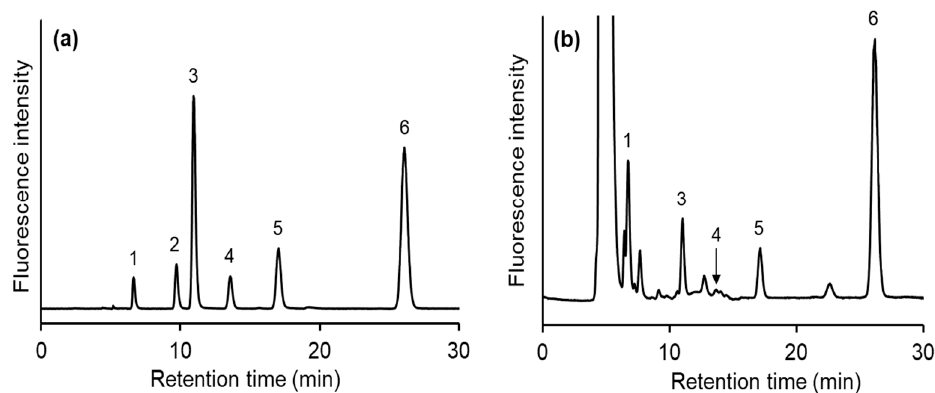
Figure 2. Chromatograms of ( a ) the SBD-thiol standards and ( b ) the K562 cell sample. Mobile phase: 100 mM citric buffer (pH 3.0)/MeOH (95/5, v / v ). Column: InertSustain AQ-C18 (250 × 3.0 mm I.D., 5 µ m). Peaks: 1; SBD-Cys, 2; SBD-Hcy, 3; SBD-CysGly, 4; SBD- γ GC, 5; SBD-GSH, 6; SBD-NAC.